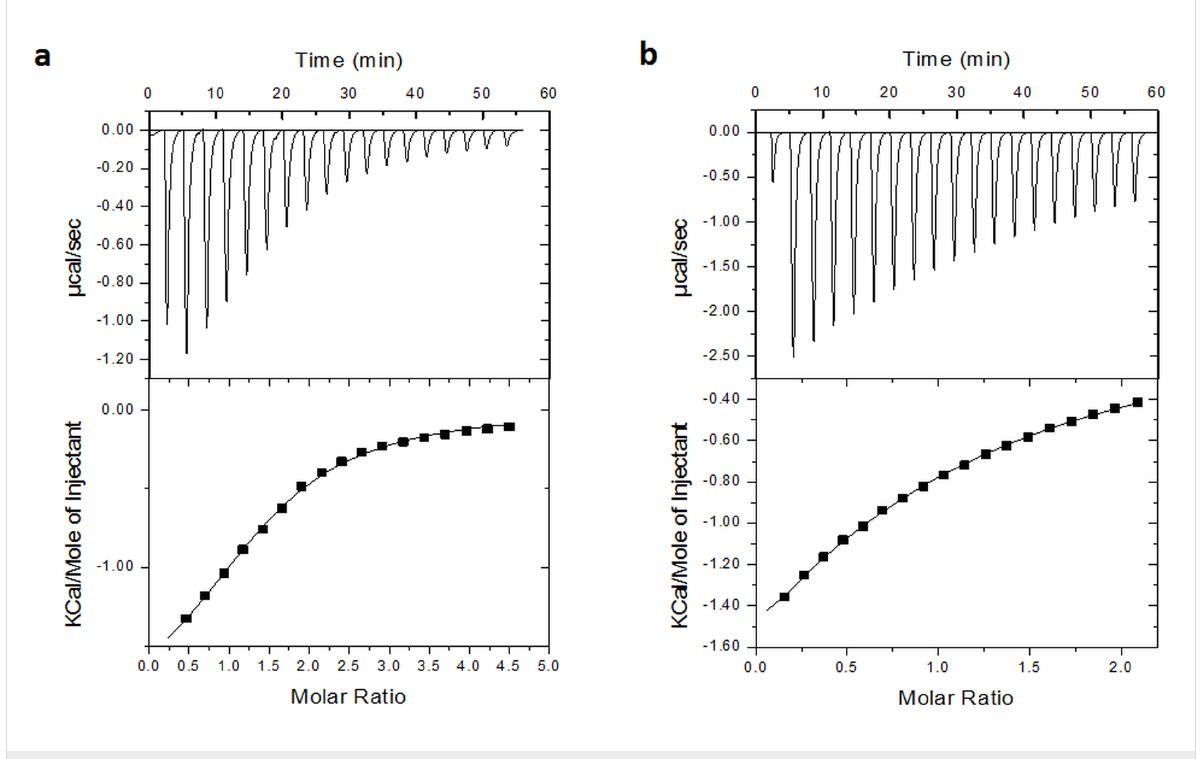
Figure 1: Titration of a) D70GP-CPT2 and b) D10GP-CPT1 by D70HP β -CD at 298 K showing heat flow as a function of time and integrated heat vs the molar ratio (enthalpogram).